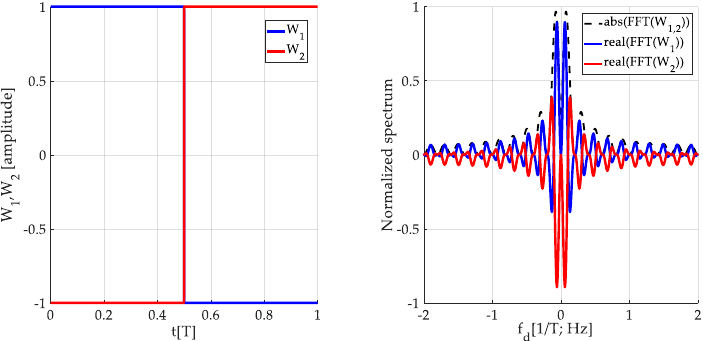
Figure 16. Description of W 1 and W 2 -function in the time domain ( left ) and the spectral domain ( right ) for τ = (1/2) T .